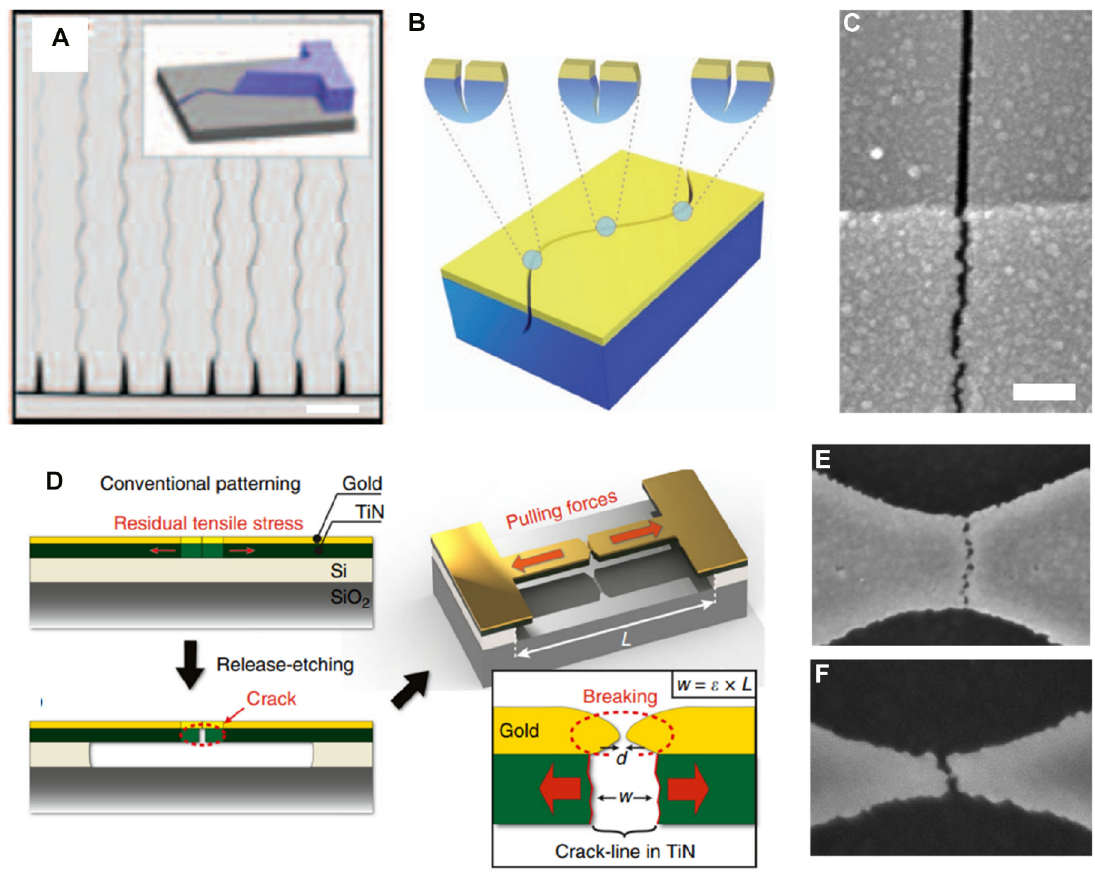
Figure 16: Nanopatterning with controlled cracking. (A) Patterning of an array of oscillating slits with cracks, initiated by a notch structure. (B) Formation of cracks by strain-controlled silicon nitride films deposited on a silicon substrate. (C) Metallic nanogaps fabricated on top of a silicon nitride film. (D) Schematic description of patterning parallel metallic gaps with pre-embedded crack lines in titanium nitride films. (E) and (F) Created metallic gaps with different bar widths. Scale bar: 100 nm (C). Reproduced with permission from [28] (A) and (B) [181], (C) [182], (D) –